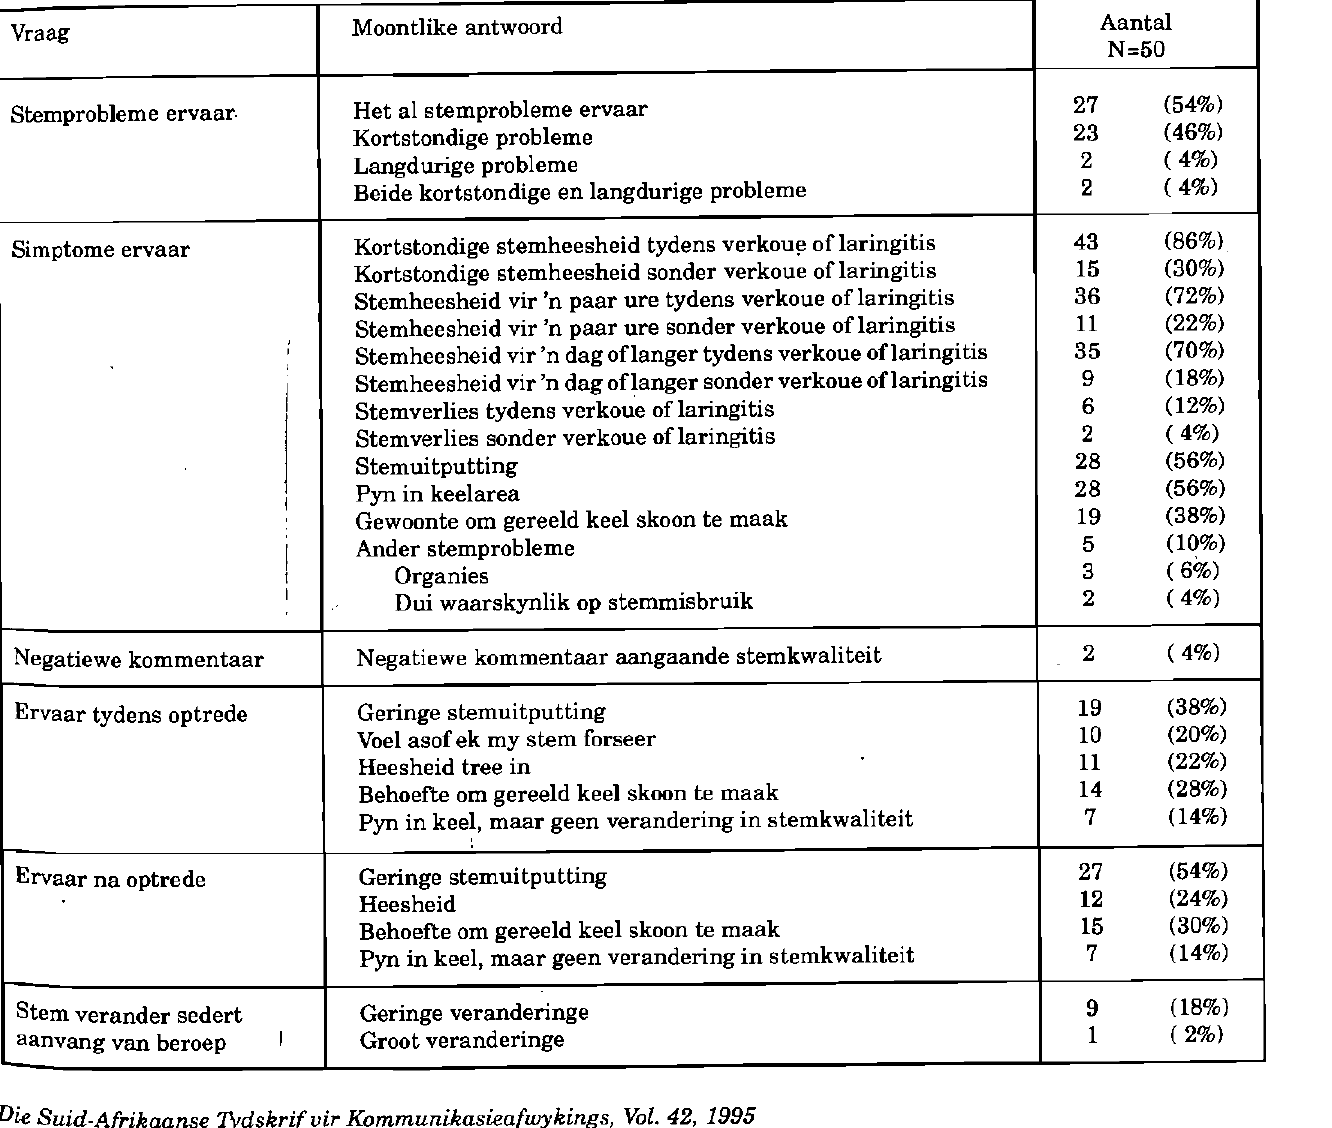
Stemprobleme ervaar Het al stemprobleme